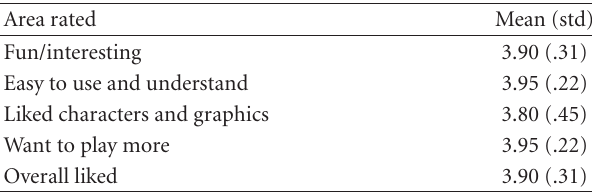
Table 1: Student usability ratings of Zoo U